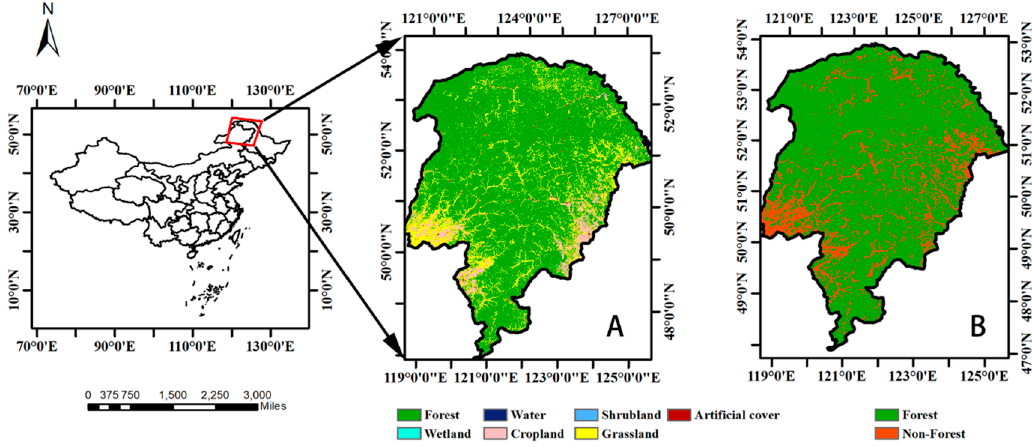
Figure 1. Map showing the location of the study area. ( A ) Land cover map of study area in 2003 produced by Landsat images of 30 m resolution; ( B ) Land cover mapping with 1000 m resolution.